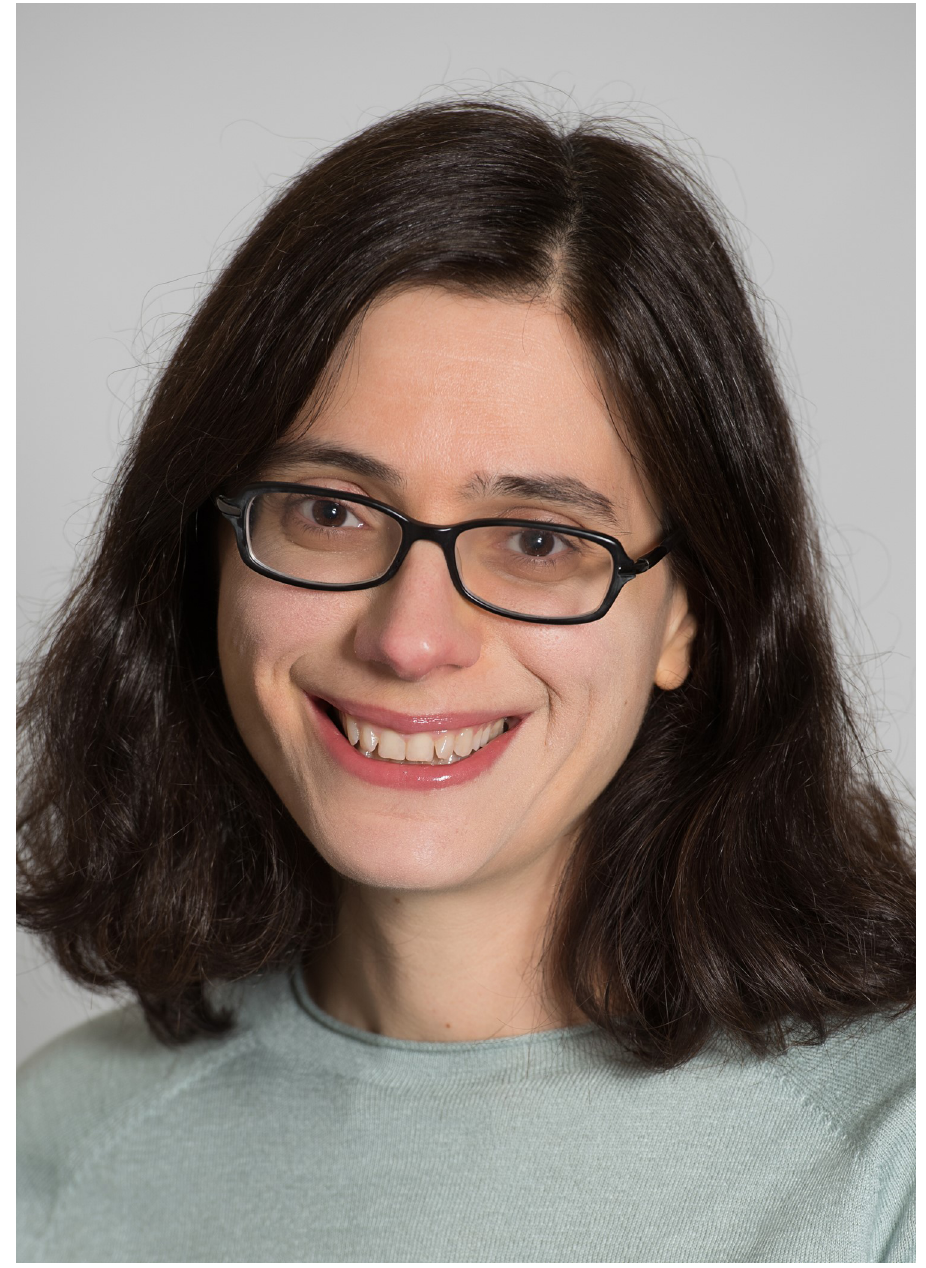
Fig 1. Aviv Regev. Image credit: courtesy of the Parker Institute for Cancer Immunotherapy.